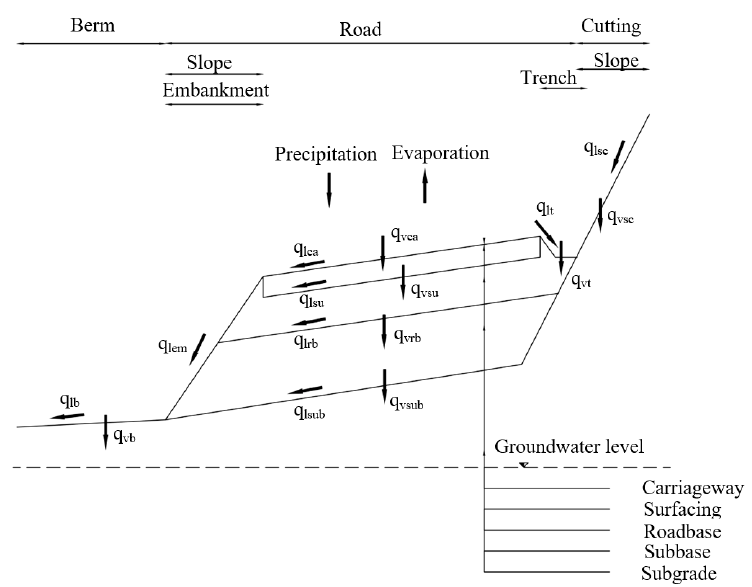
Figure 1. Conceptual model of water balance on pavement–embankment system: v—vertical, l—lateral, ca—carriageway, su—surfacing, rb—roadbase, sub—sub-base, sc—slope/cutting, t—trench, em—embankment, b—berm [7].